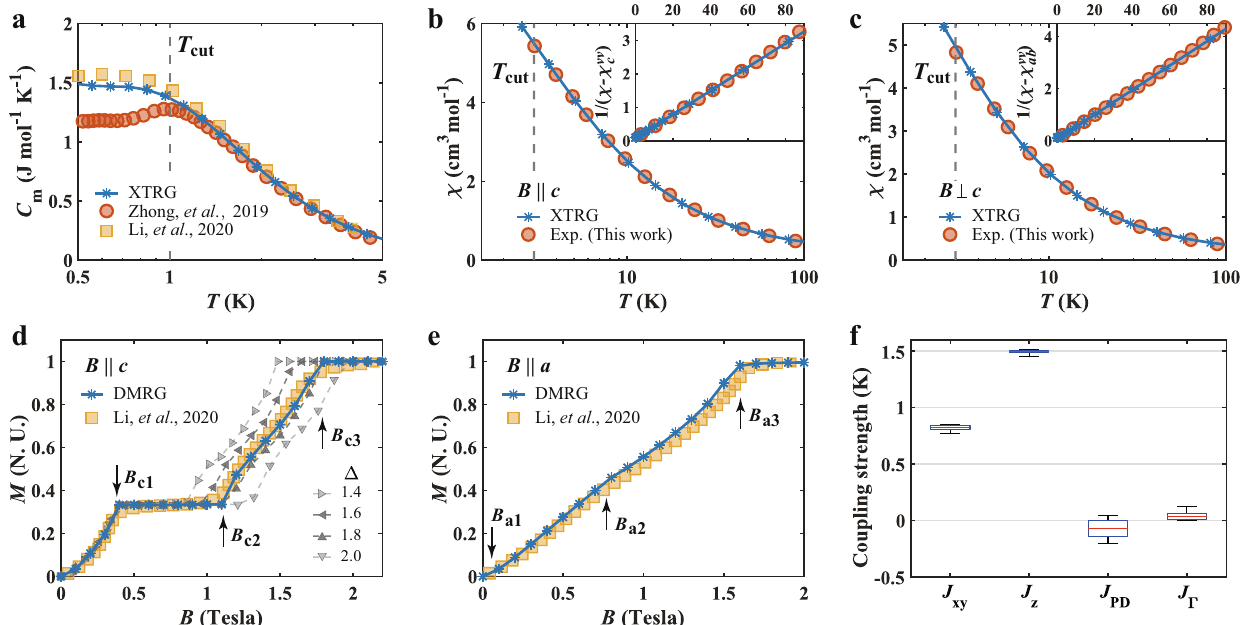
Fig. 2 Thermodynamic data fi ttings, magnetization curves, and the optimal model parameters. a Shows the magnetic speci fi c heat C m of the NBCP as a function of temperature T , reported by two independent measurements (Zhong et al. 14 and Li et al. 15 ) as well as the best fi t. The gray dashed line marks T cut . The XTRG fi tting is performed for experimental data at T > T cut . b , c Show respectively parallel and perpendicular to the c -axis magnetic susceptibilities with the experimental data measured in this work (see Methods) and the best fi t. d , e Show the magnetization as a function of the magnetic fi eld in the c and a directions, respectively. The experimental data were obtained from Li et al. 15 with the van Vleck paramagnetic contributions subtracted off. The model prediction is obtained from DMRG, which agrees quantitatively with experiment. The gray lines show magnetization curves obtained from models with various anisotropy parameters Δ , with J xy tuned to the optimal value. f Shows the standard box plot of the optimal parameters, with the red line indicating the median value, the top(bottom) edge of the box representing the upper(lower) quartile of the best 20 model parameter sets found in 450 Bayesian optimization